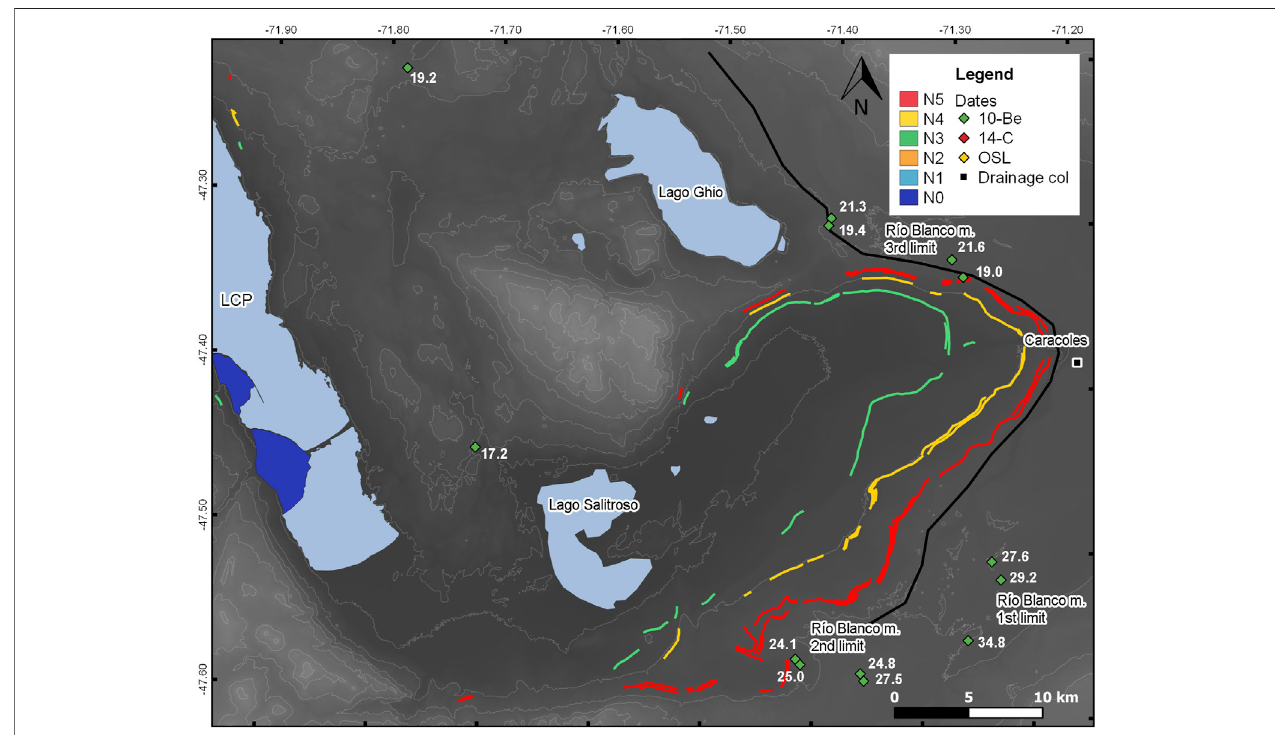
FIGURE 2 | Distribution of shoreline-related landforms in the eastern sector of LCP, grouped according to their elevation in N5 ( ∼ 600 – 500 m), N4 ( ∼ 470 – 400 m), N3 ( ∼ 360 – 300 m), N2 ( ∼ 230 – 220 m), N1 ( ∼ 180 – 170 m), and N0, which correspond to active deltas. Lines represent paleo-shorelines (beaches, wave-cut scarps and benches,anddeltabrink-points)andpolygonsdeltas.Geochronologicaldataareshowninka,withoutuncertainty(seedetailsin SupplementaryTablesS1 – S3 ).Black lines represent ice